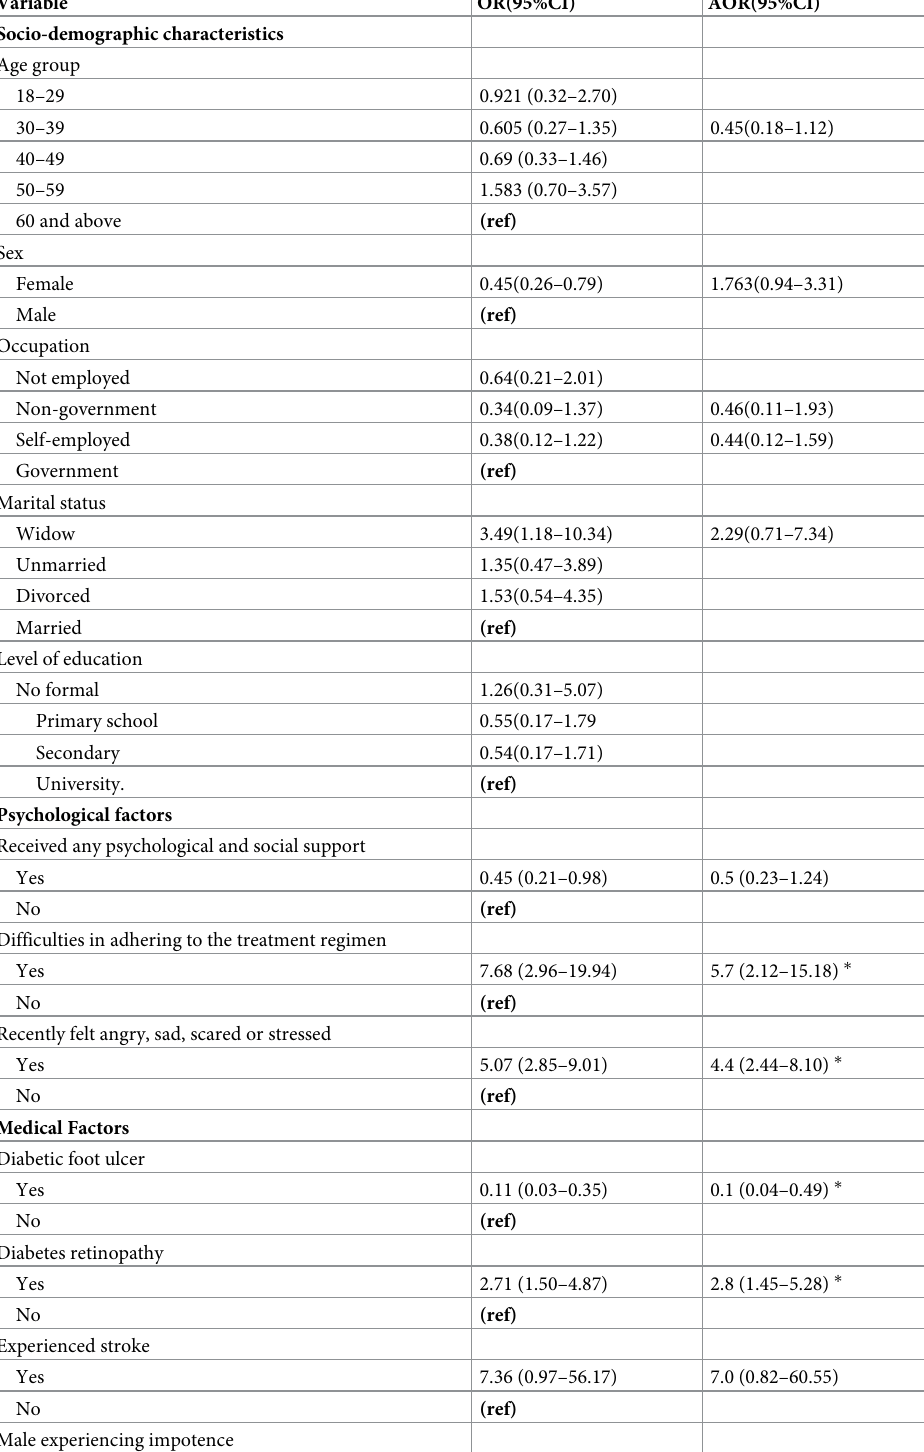
Table 2. Association between socio-demographic, psychological, medical factors and depression among patients attending Diabetic Clinic at Mnazi Mmoja Hospital,